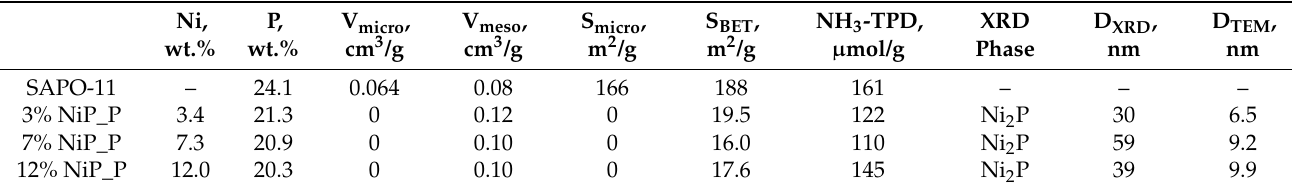
Table 2. Physicochemical properties of NiP_P